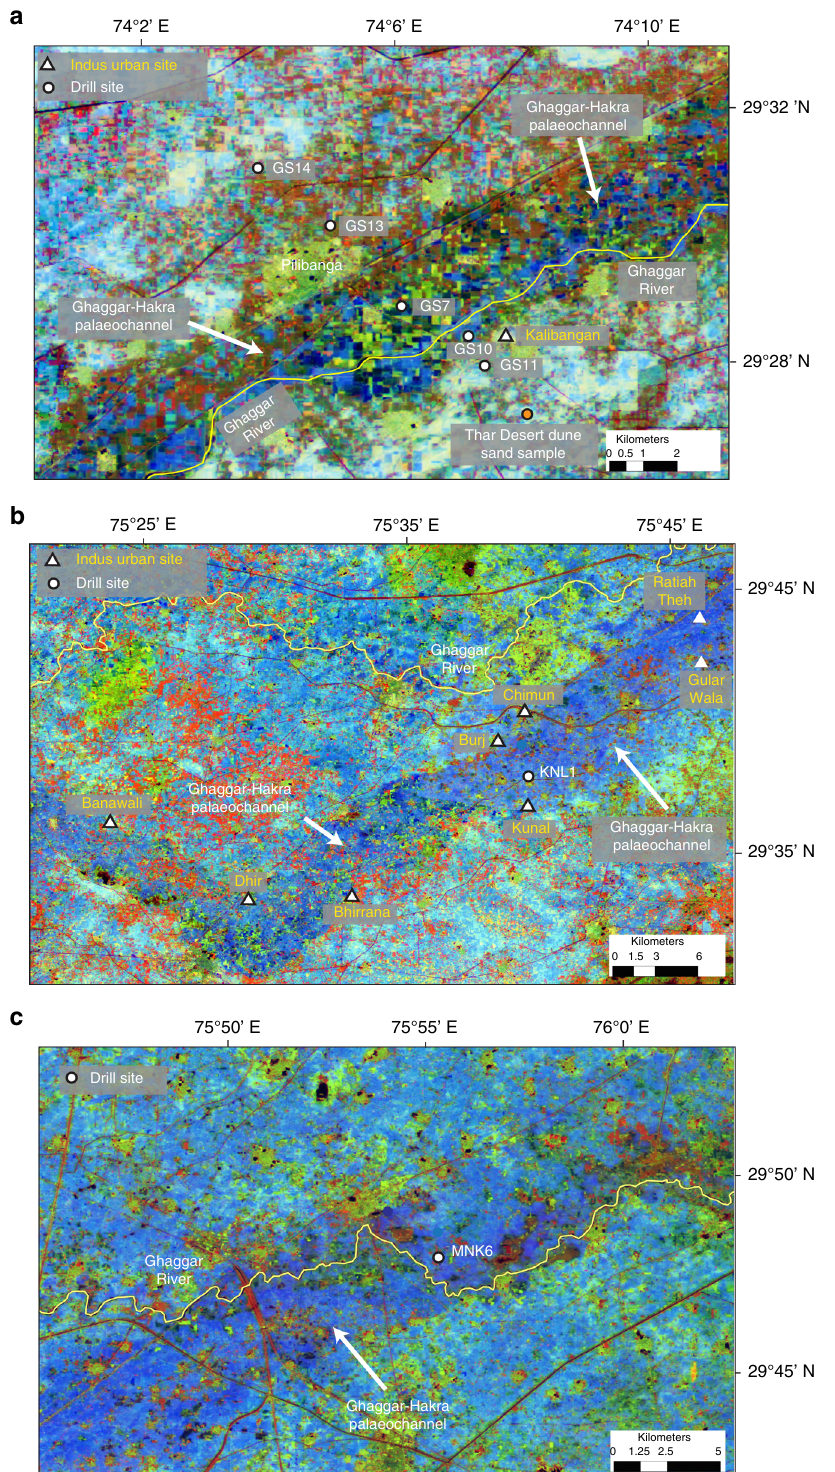
Fig. 4 Locations of core sites along Ghaggar – Hakra palaeochannel. Background images are derived from Landsat 5 TM colour composite satellite mosaic shown in Fig. 2. White circles show locations of cores with relationship to Ghaggar – Hakra palaeochannel (dark blue tone). Course of modern ephemeral Ghaggar River is indicated in yellow. a Vicinity of Kalibangan Indus urban centre showing locations of cores GS14, GS13, GS7, GS10 and GS11. Location of Thar Desert modern dune sample also indicated. b Location of core KNL1. Urban-phase Indus archaeological sites in area are indicated by white triangles. c Location of core MNK6. Locations of all drill sites tabulated in Supplementary Table